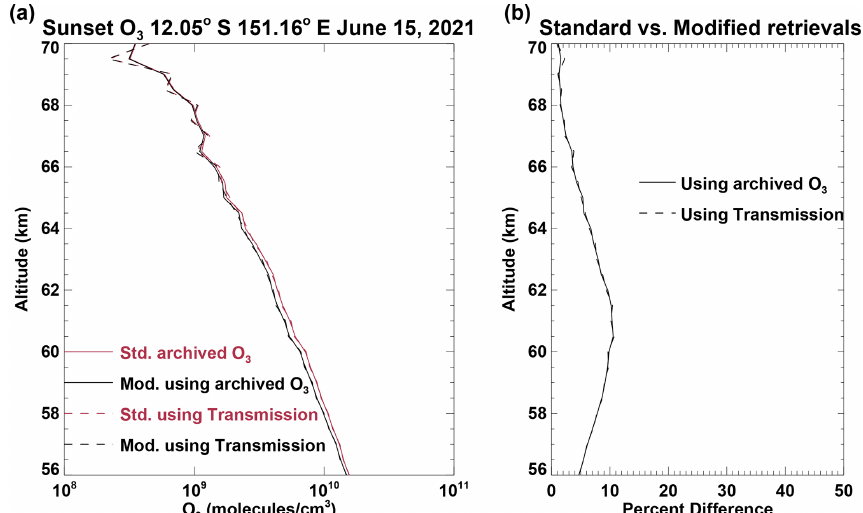
Figure 8. SAGE III/ISS O 3 for a sunset event at 12.05 ◦ S and 151.16 ◦ E on 15 June 2021 (Event ID 2021061515SS). (a) Red solid line shows the standard SAGE III retrieval, and the black solid line represents the retrieval including the diurnal variations along LOS. The dashed lines represent the retrievals using the transmission data, the red color for the standard retrieval and the black denoting the retrieval with diurnal corrections. (b) Percent difference between the standard retrieval and the one with diurnal corrections; solid line using the archived standard retrieval of O 3 concentration, and the dashed line based on the approximate retrieval using the transmission